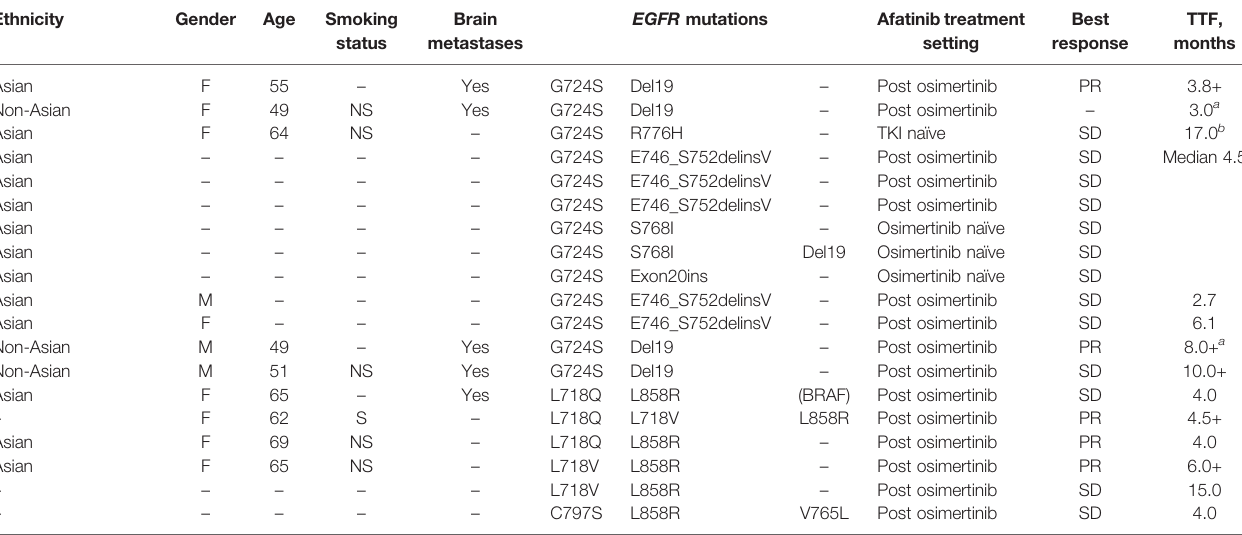
TABLE 3 | Outcomes in patients with NSCLC harboring uncommon EGFR mutations which are known to be resistance mechanisms to osimertinib.